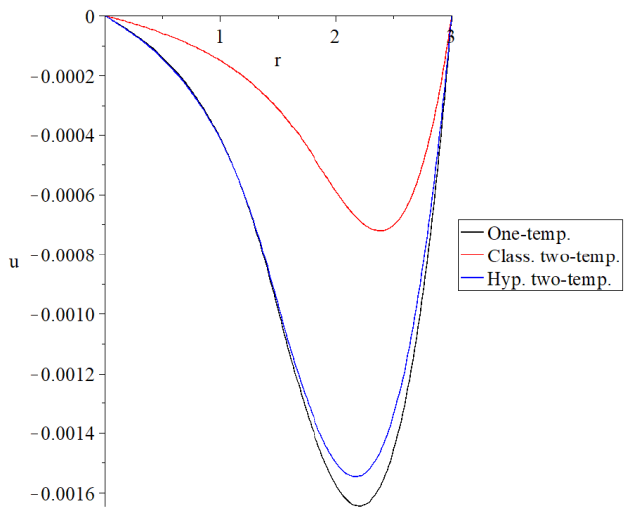
Figure 5. The distribution of the displacement for the variance values of the two-temperature parameter when D = 0.2.